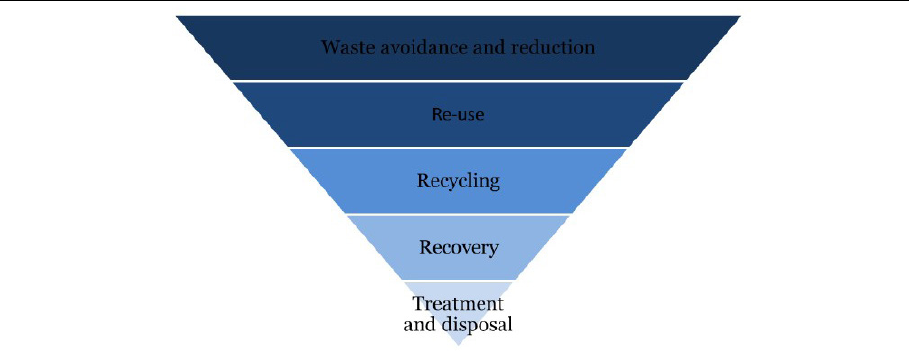
Figure 1: Illustration of the waste management hierarchy.